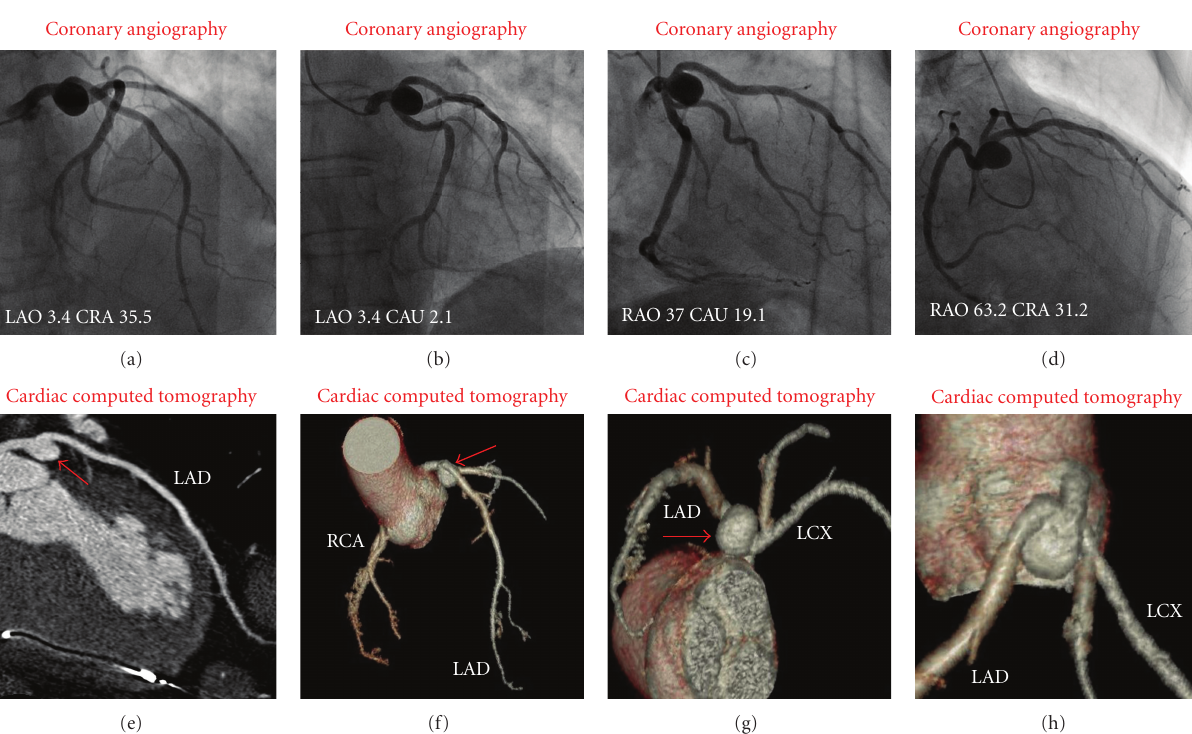
Figure 1: Images of the coronary aneurysm by coronary angiography ((a)–(d)) and cardiac computed tomography angiography ((e)–(h)). Red arrows point to the coronary aneurysm. LAD: left anterior descending, LCX: left circumflex coronary artery; LAO: left anterior oblique, and RAO: right anterior oblique